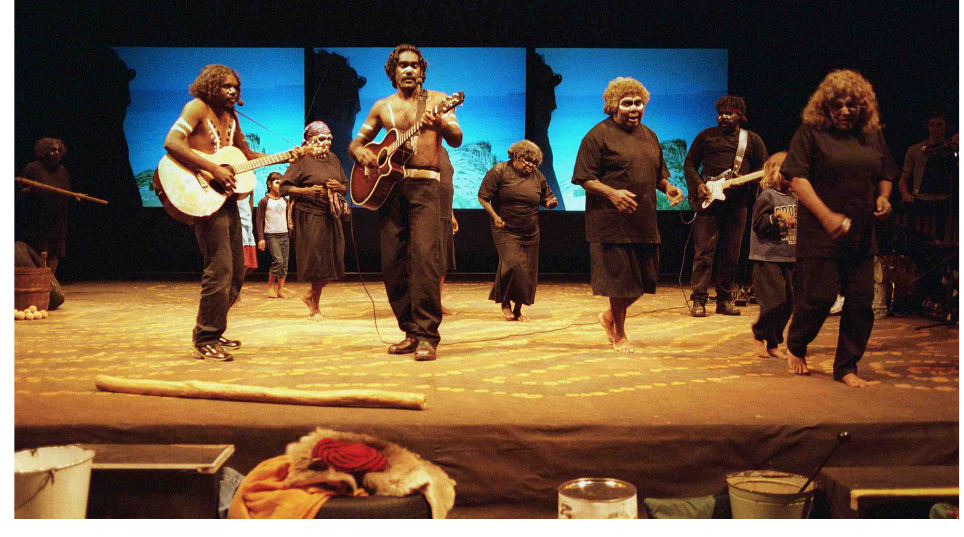
Spinifex community members with Trevor Jamieson in a performance of Career Highlights of the Mamu at the Adelaide Festival, 2002 (photo: courtesy Black Swan Theater